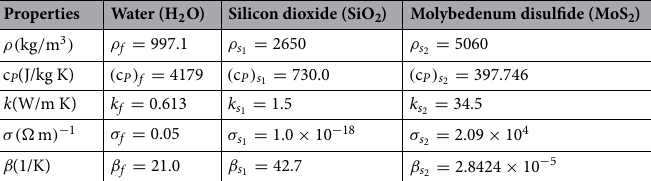
Table 1. Thermophysical properties of water and nanoparticles 46